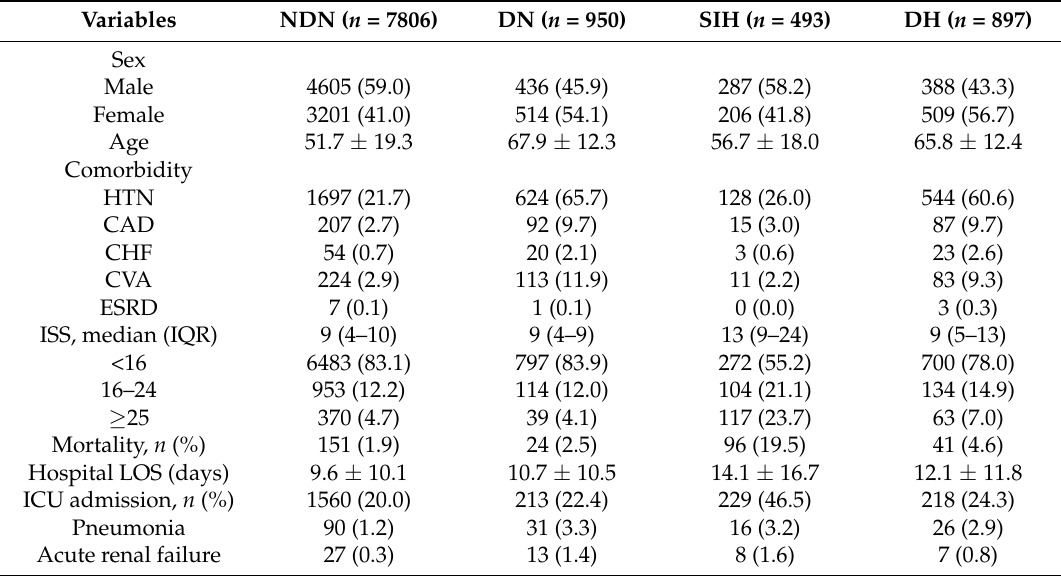
Table 1. Characteristics, injury severities, and outcomes of the